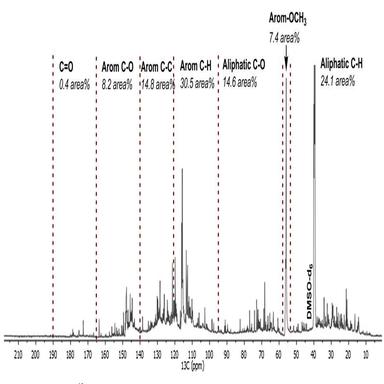
13C- NMR spectrum of PL and integration results of assigned regions (solvent: DMSO-d6).